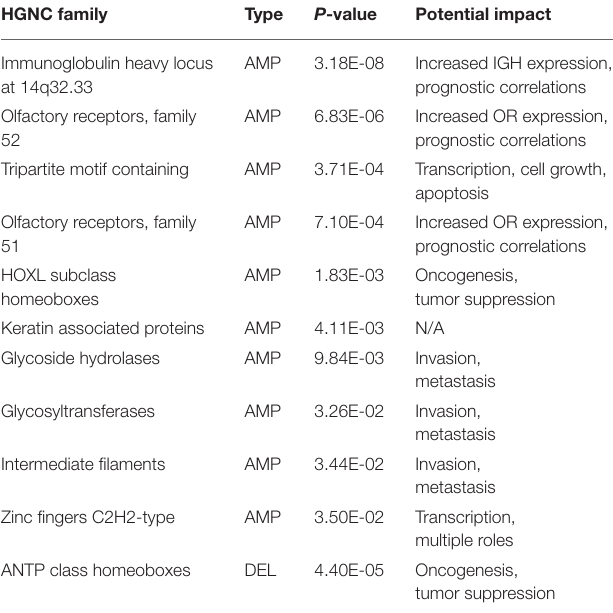
TABLE 4 | The significant HGNC gene families of the 927 feature genes, where the family is covered by at least five genes and with the Binomial test < 0.05. HGNC family Type P